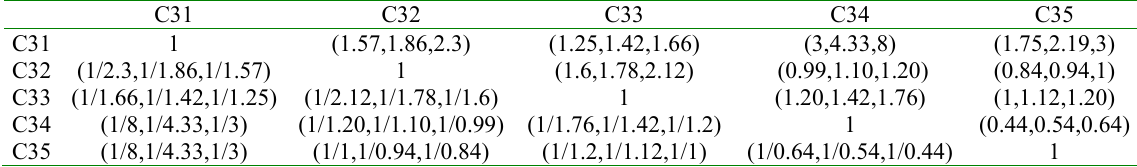
Table 20. Fuzzy aggregated evaluation matrix C3 sub-criteria